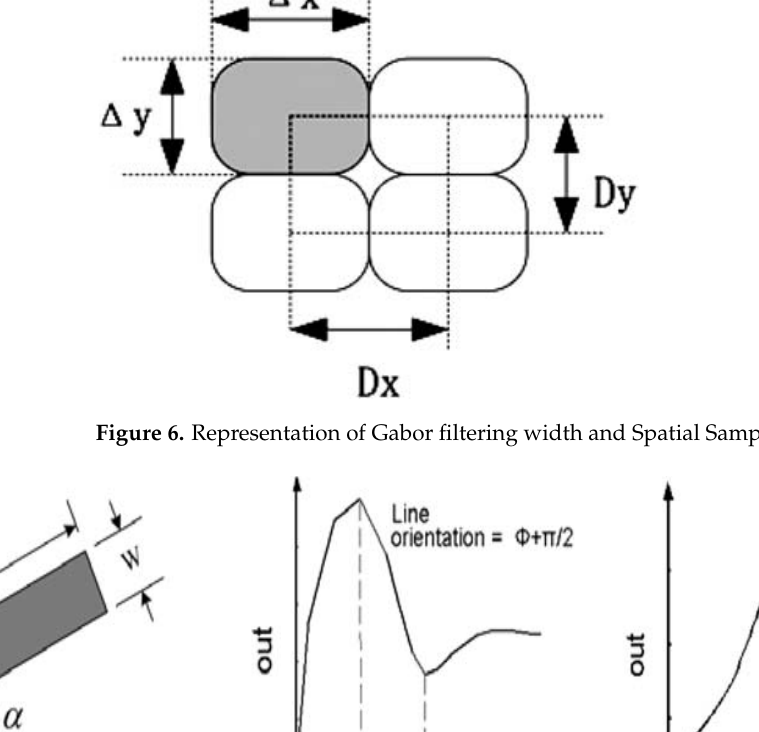
Algorithm 1: An algorithm for the Gabor filter for feature extraction Input: images after resizing